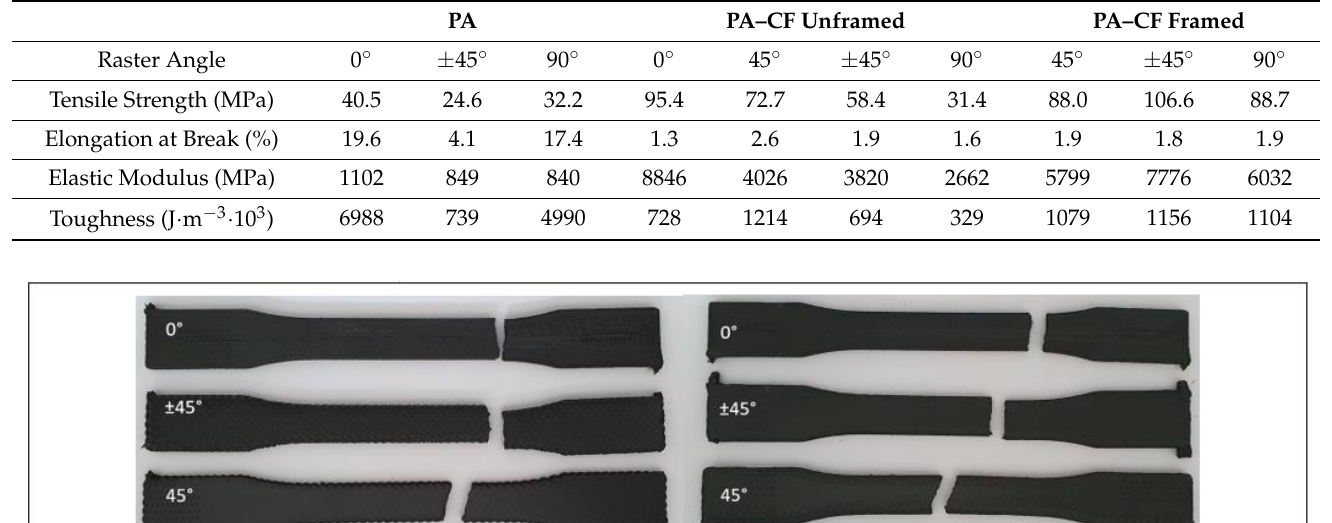
Table 4. Tensile properties of PA and PA–CF.